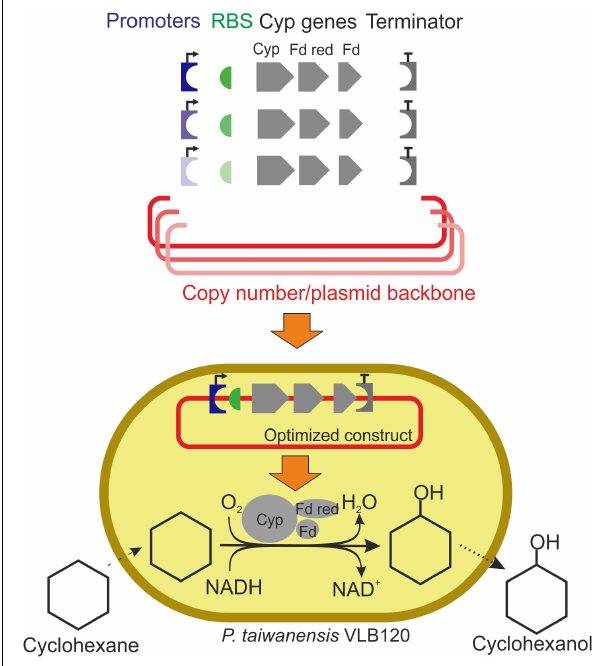
FIGURE 1 | Schematic workflow of expression vector engineering to enhance cytochrome P450 monooxygenase (Cyp) gene expression and cyclohexane oxidation rates. The Cyp genes encode the three components of this enzyme system: the oxygenase (Cyp), the ferredoxin reductase (Fd red), and the ferredoxin (Fd). Plasmid backbones, promoters, RBSs, and a terminator were assembled in different constellations. Varied components are shown in colors with different intensities. Specific whole-cell activities and growth rates of resulting strains were evaluated. Specific activities are calculated based on the amount of cyclohexanol